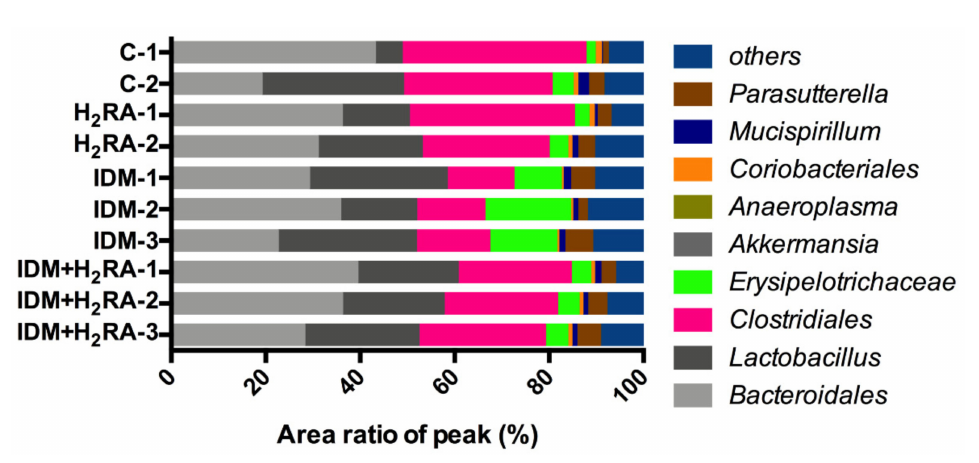
Figure 3. Constitution of intestinal flora in the feces of Indometacin (IDM)-induced intestinal mucosal injury model with or without histamine H 2 -receptor antagonists (H 2 RA) administration. On the second day after IDM administration, we conducted a T-RFLP using the feces of 10 mice (2 control, 2 H 2 RA only, 3 IDM, and 3 IDM + H 2 RA mice). The area ratio of peaks of the bacterial classification groups corresponding to each operational taxonomic unit (OTU) was presented for each classification group. The final number indicates the individual mouse